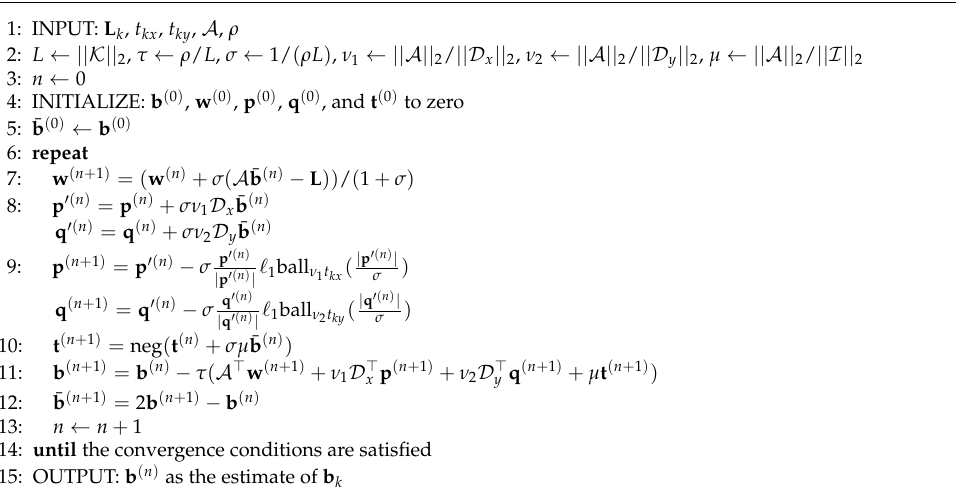
Algorithm A1 Pseudo-code of the DTV algorithm for solving Equation